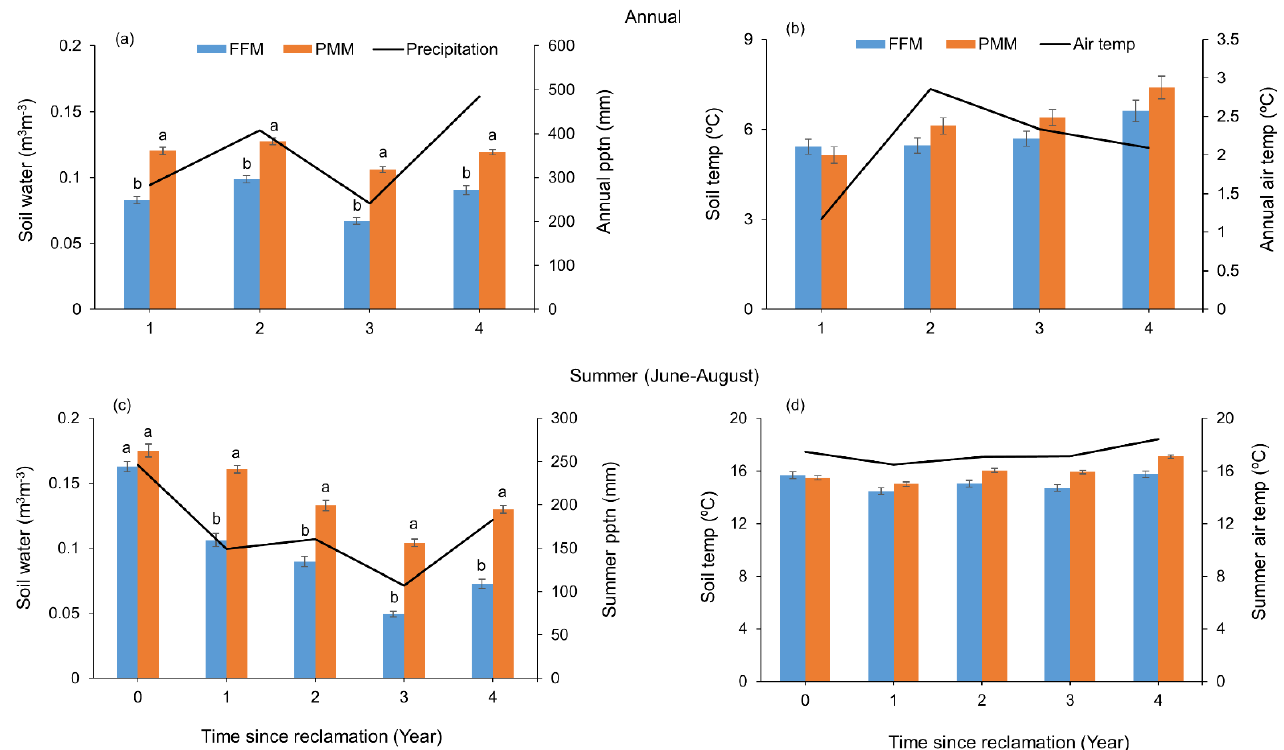
Figure 3. ( a – d ) Mean annual and summer soil water content and temperature by cover soil type, at the research sites including precipitation and air temperature. Different letters indicate significant differences at p = 0.05 in the Tukey HSD post hoc comparisons. FFM = forest floor mineral soil mix; PMM = peat minerals soil mix, pptn = precipitation, temp = temperature.